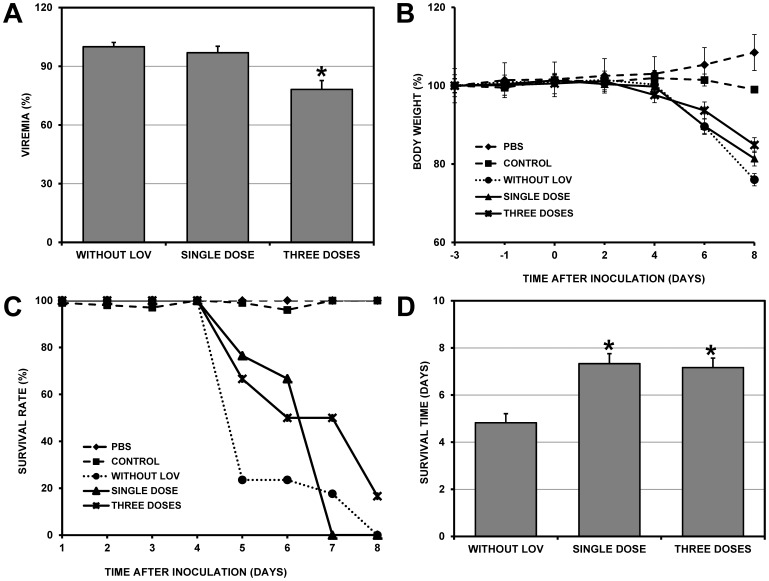
Effect of LOV treatment before viral inoculation (pre-treatment).Groups of six mice were treated with LOV (200 mg/kg/day) orally prior to intraperitoneal inoculation with 1×106 PFU/ml of virus. One group was treated with a single dose (24 hrs before viral inoculation), and the other group was treated with three doses (72, 48 and 24 hrs before viral inoculation). Three types of controls groups were used. The “PBS” group consisted of mice that were not treated with LOV and were not infected, the “CONTROL” group consisted of mice that were treated with LOV but were not infected and the “CONTROL WITHOUT LOV” group consisted of mice that were not treated with LOV but were inoculated with DENV-2. The viremia and survival rates were compared between the control without LOV group and the treated groups (single- and three-dose groups). A. Plaque assay of infected VERO cells to quantify serum viremia at 3 dpi. Bars represent the standard error of the mean (SEM). B. Average body weight percentage, recorded every two days until the animals died or were sacrificed. C. Kaplan-Meier curve showing the survival rates of the untreated group and groups treated with one or three doses of LOV. D. Comparison of survival rates between the untreated group and groups treated with one or three doses. Asterisks in A and D indicate statistically significant differences between the treated LOV groups and the control without LOV group. In the group pre-treated with three LOV doses, there was a significant reduction in viremia. Moreover, the survival rates were increased in both groups (pre-treated with one or three doses).